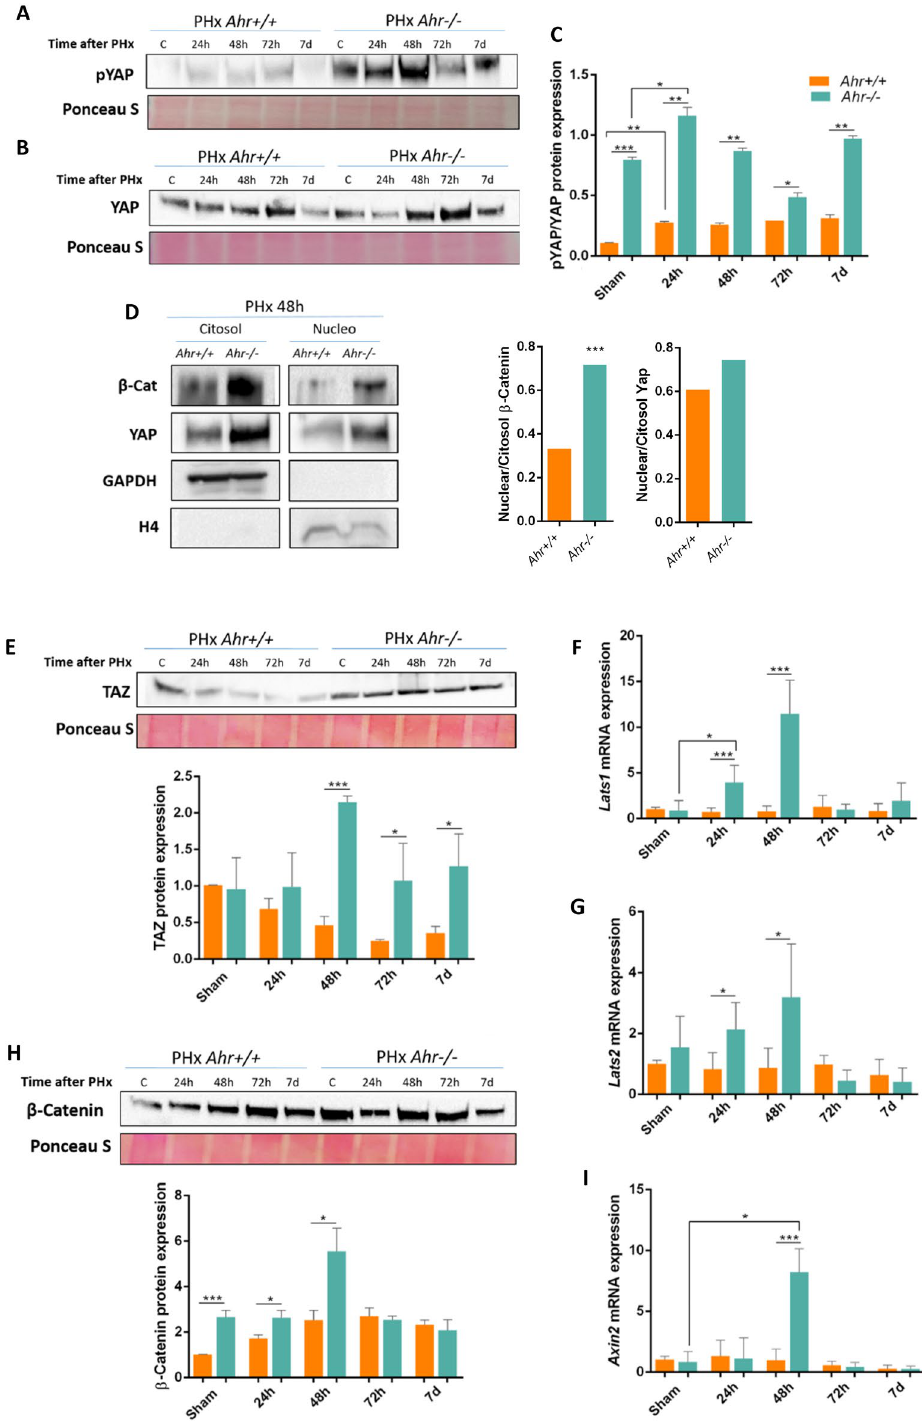
Figure 7. Ahr-null livers show deregulation of Hippo and Wnt signalling pathways. p-YAP protein expression ( A ) and p-YAP ( B ) was analyzed in liver extracts of Ahr + / + and Ahr −/− liver samples at the indicated points after PHx by immunoblotting. Cytosolic and nuclear levels of β-Catenin and YAP were determined by immunoblotting using specific antibodies ( D ). GAPDH and Histone H4 were used as controls for cytosolic and nuclear protein, respectively. Protein expression of the Hippo pathway effector TAZ ( E ) and mRNA expression of the YAP and TAZ kinases Lats1 ( F ) and Lats2 ( G ). Protein levels of β-Catenin ( H ) were analyzed by immunoblotting whereas the β-Catenin pathway transcriptional target Axin2 (I ) was quantified using RT-qPCR under the same experimental conditions. Gapdh was used to normalize target gene expression (ΔCt) and 2 −ΔΔCt to calculate changes in mRNA levels with respect to sham-surgery control mice. Ponceau staining was used to normalize protein levels. *p < 0.05, **p < 0.01, ***p < 0.001. Data are shown as mean ± SD. The experiments were performed using three mice per time point and three technical replicates were done. Oligonucleotides and antibodies used are indicated in Supplementary Tables 1 and 3,